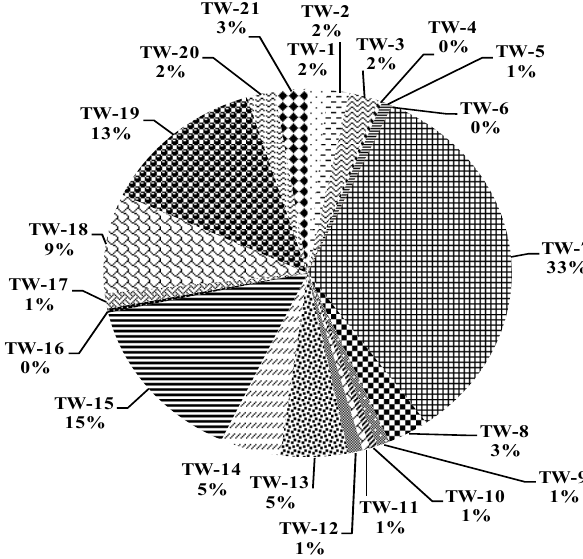
Figure 5. Relative abundance of OCP in different Ranney well samples (Post-monsoon) Figure 4. Relative abundance of OCP in di ff erent borewell samples (Post-monsoon).